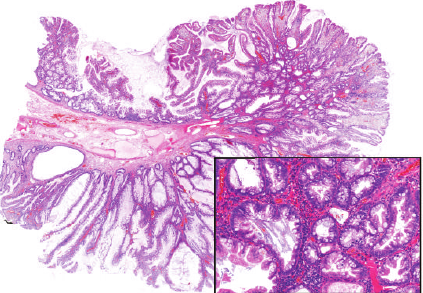
Figure 14: Traditional serrated adenoma of the colon with low- grade dysplasia (hematoxylin-eosin, original magnification 2x). Inset: serrated morphology and eosinophilic cytoplasm of tumour cells are evident (hematoxylin-eosin, original magnification 10x).